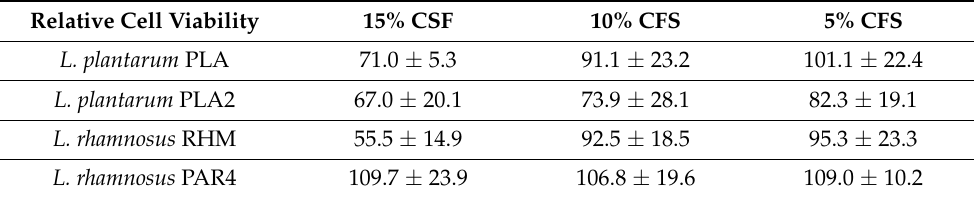
Table 2. Cytotoxicity studies. Toxic effects of different percentage (15%, 10%, 5% ( v/v )) of CFS on viability of THP-1 macrophages. Relative cell viability (%) = [(OD 595 sample − OD 595 blank)/(OD 595